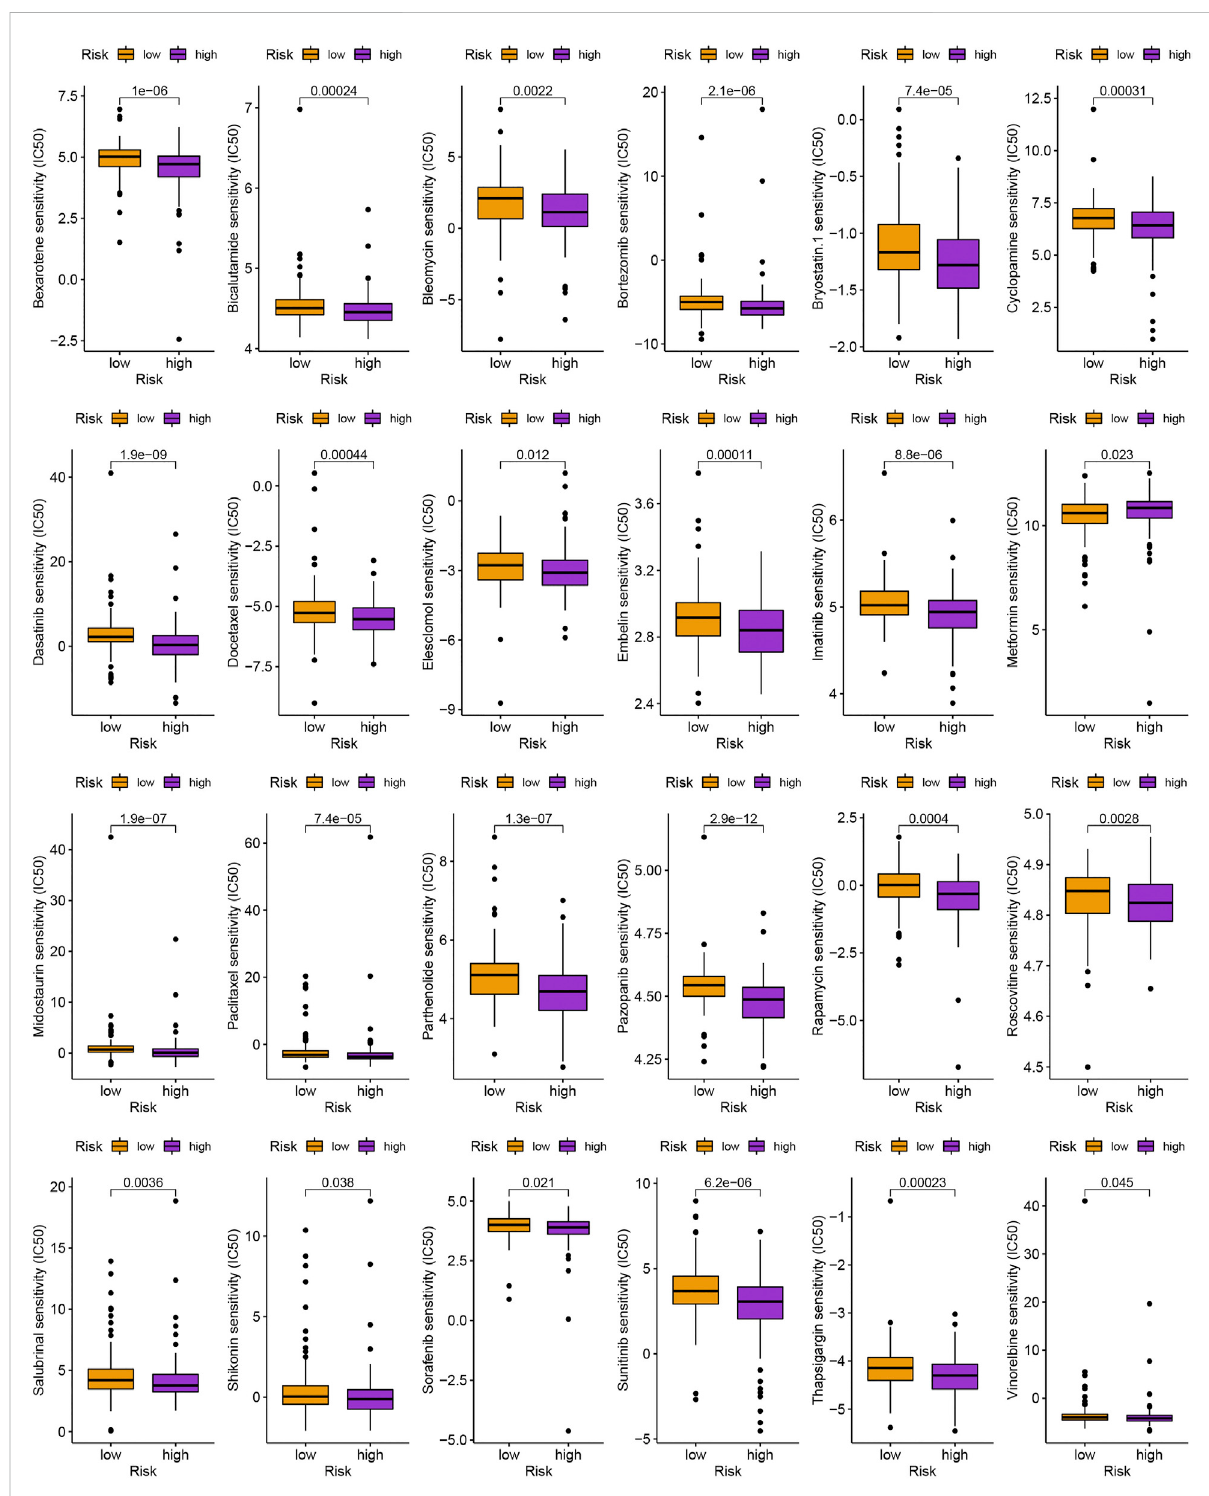
FIGURE 8 Identi fi cation of commonly used anti-tumor drugs targeting the